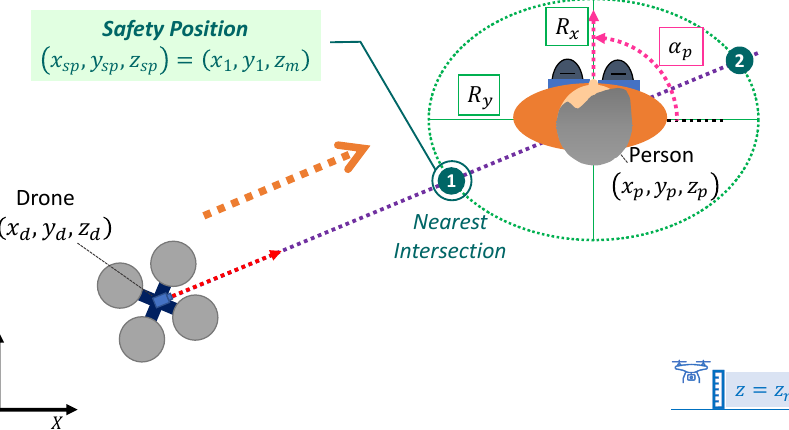
Figure 5. Determination of the safety position ( x sp , y sp , z sp ) to which the UAV is approaching to start the elliptical monitoring lap around the